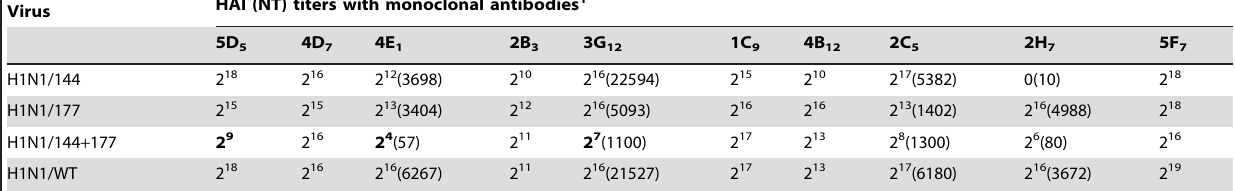
Table 4. Effect of variations at four HAs on reactivity with monoclonal antibodies.